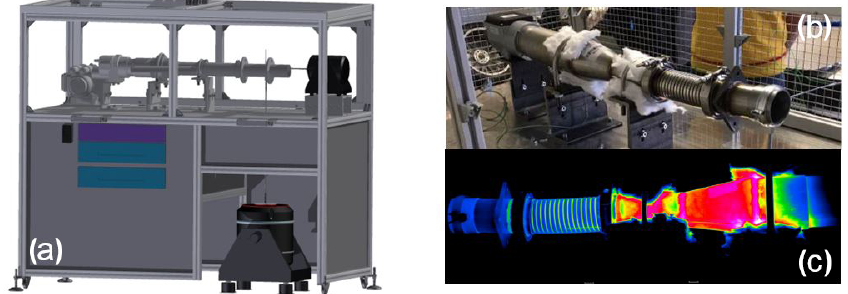
Figure 2. (a) Test rig layout consisting of several systems for heat generation and sensor stressing, (b) hot-air-exhaust test rig and (c) thermal image of the test